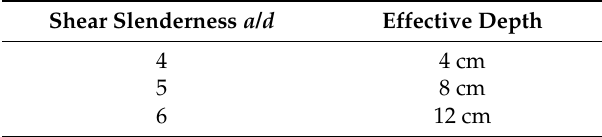
Table 1. Parameter variation for the experimental study.